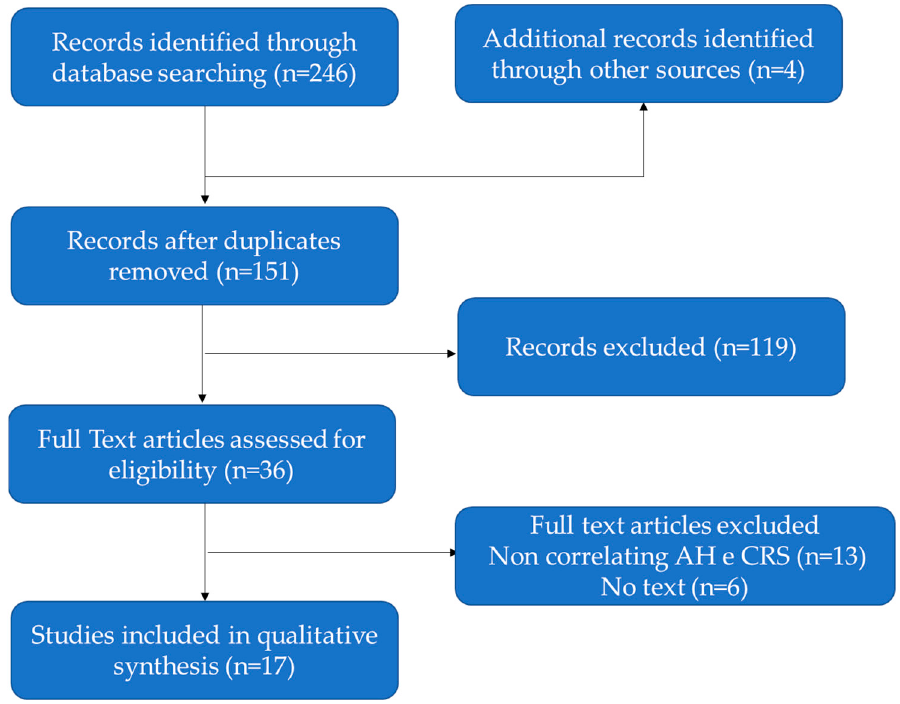
Figure 1. PRISMA chart showing the selection process of the studies included in this study.